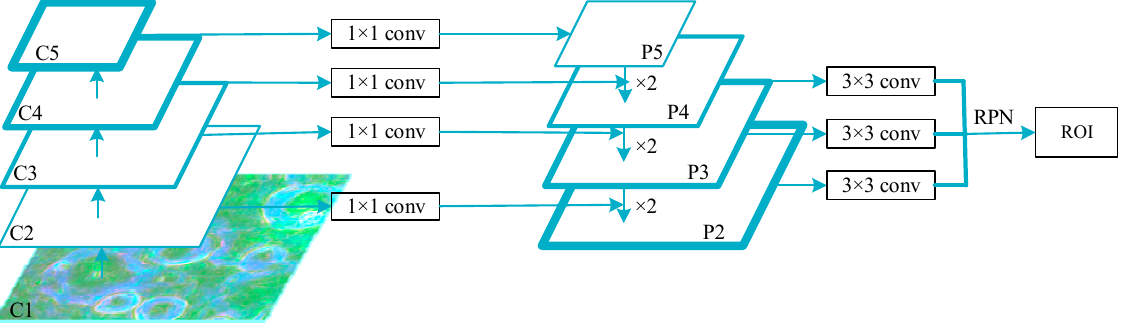
Figure 5. RPN network with FPN.